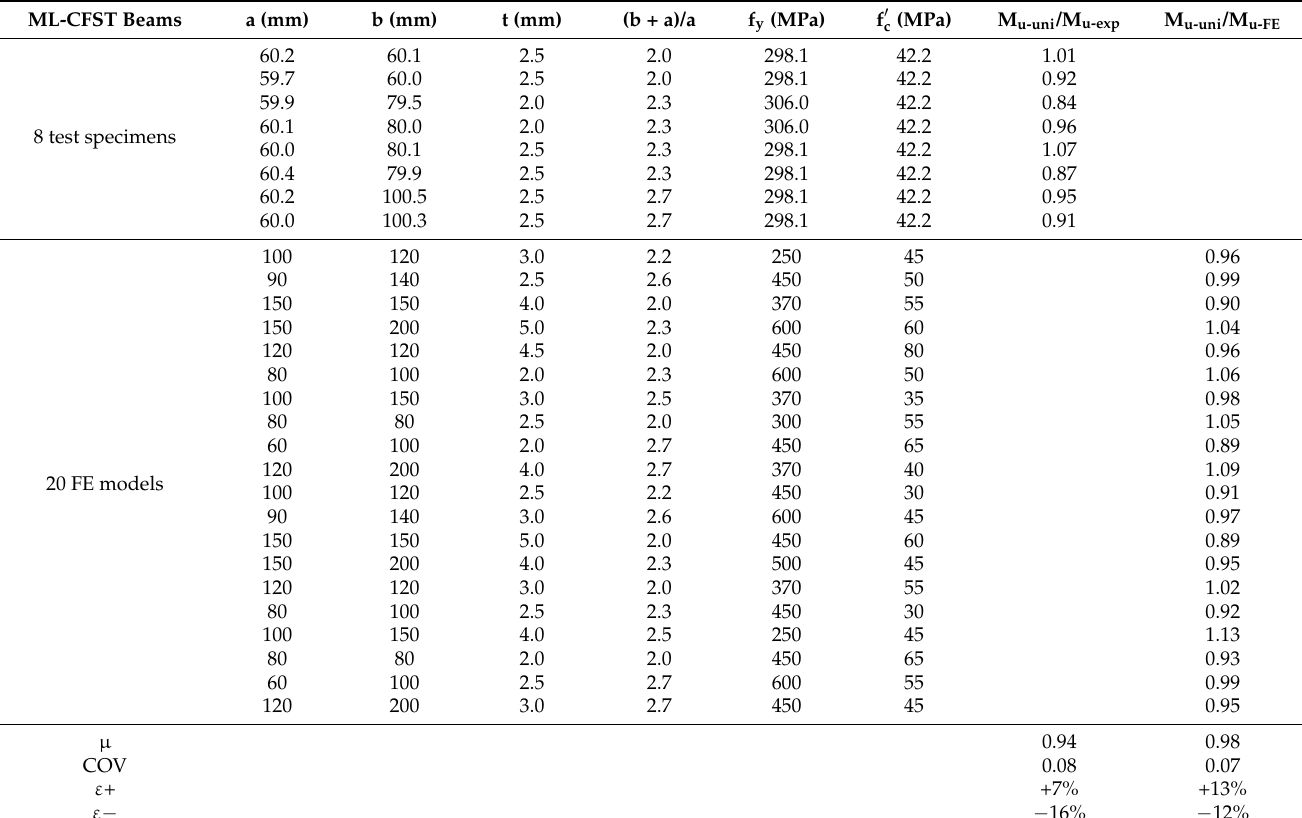
Table 2. Detailed results of M u − uni and M u − FE for the studied ML-CFST beams.